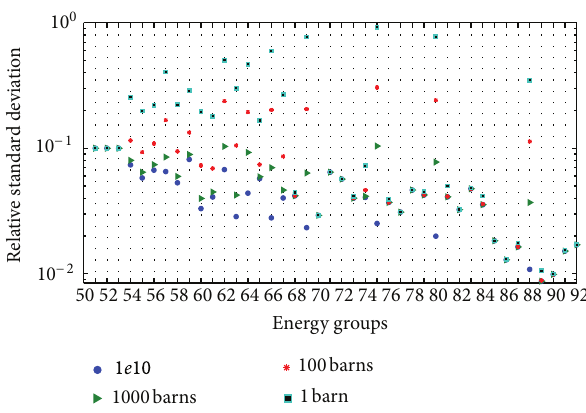
F 9: Relative standard deviation as a function of background cross-section at the resonance groups for the